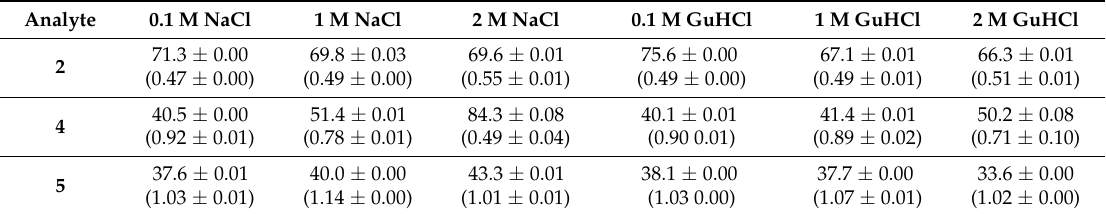
Table 4. Results of energy-transfer experiments in the presence of salt additives with compound 7 (control ratios are shown in parentheses) a